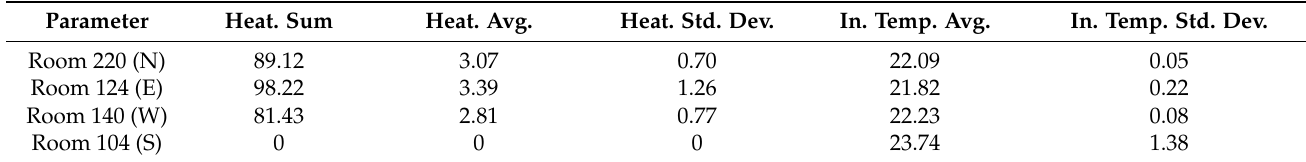
Table 8. Heating statistic parameters collected basing on daily sum of samples of valve open percentage. Parameter Heat. Sum Heat. Avg. Heat. Std. Dev. In. Temp. Avg. In. Temp. Std. Dev. Room 220